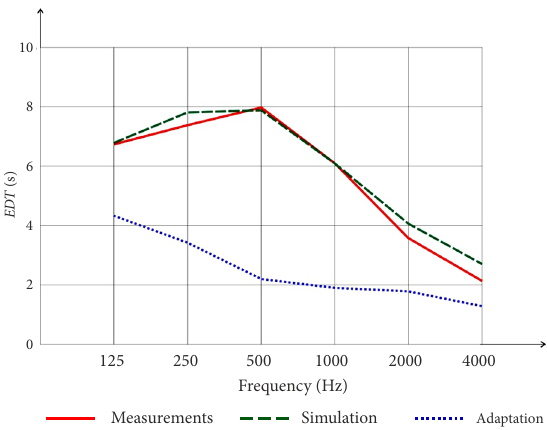
Figure 12. Graph of early decay time EDT in the frequency range – comparison of results of in situ measurements, simulation and simulation with acoustic treatment